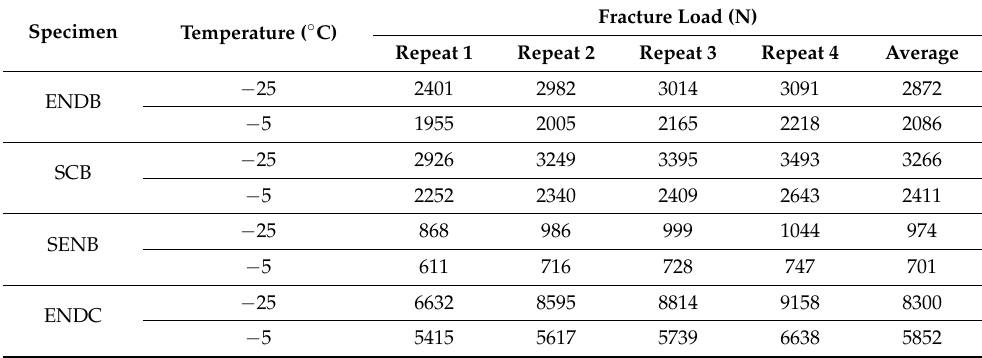
Figure 8. Typical load-displacement curves of the tested ENDB, SCB, SENB and ENDC specimens at − 25 °C. Table 3. Fracture loads of the tested specimens at low temperature conditions.